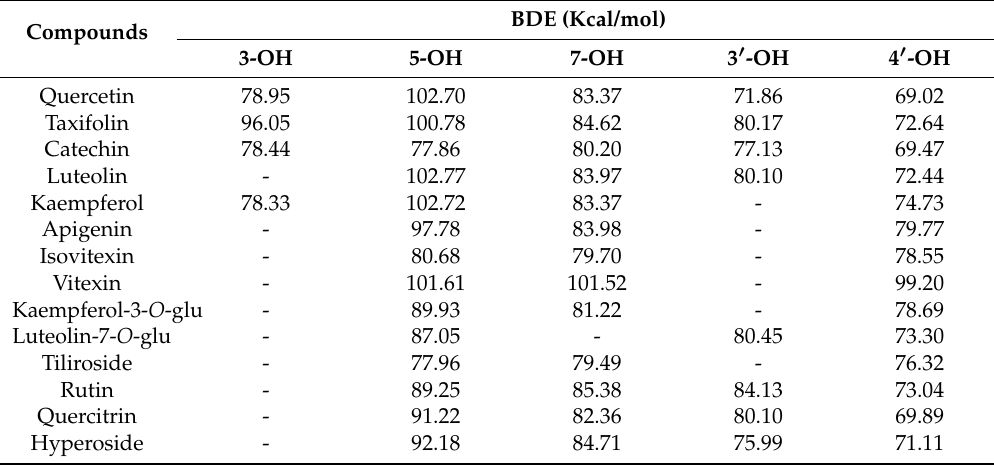
Table 2. The calculated O-H bond dissociation enthalpy (BDE) of flavonoids from Agrimonia pilosa Ledeb (Kcal/mol, 1 atm, 298 K).